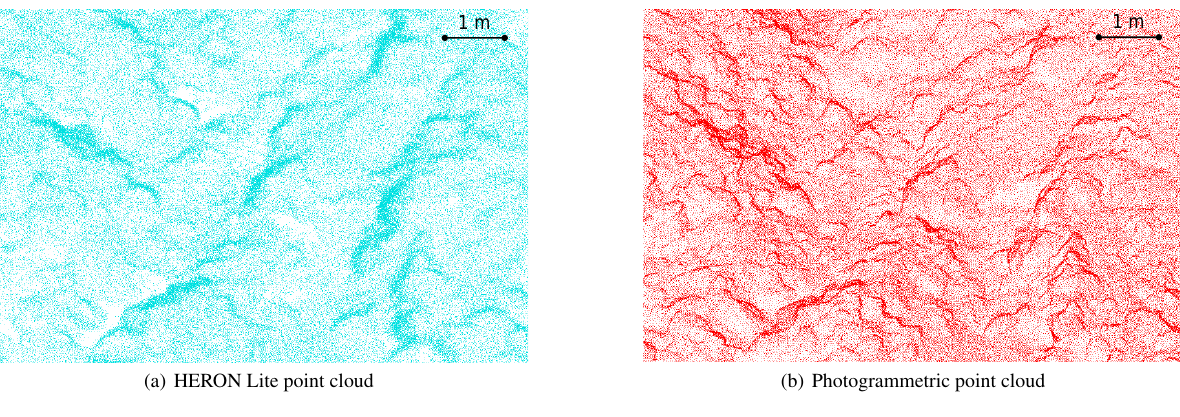
Figure 10. Detail of the point clouds, showing a portion of the